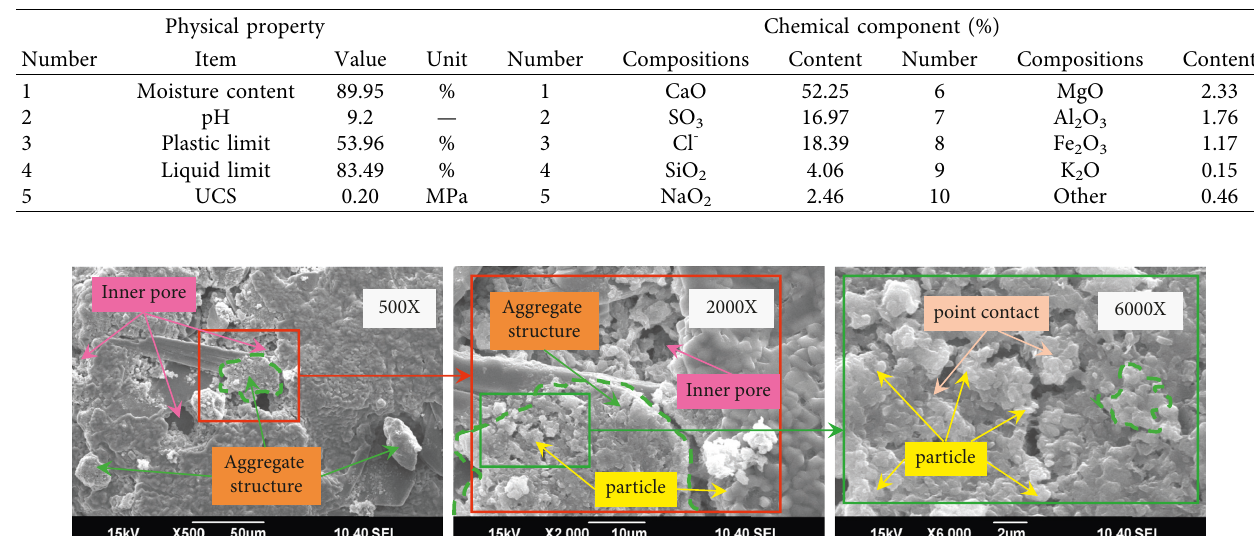
Table 1: Basic physical parameters and chemical composition of SR.